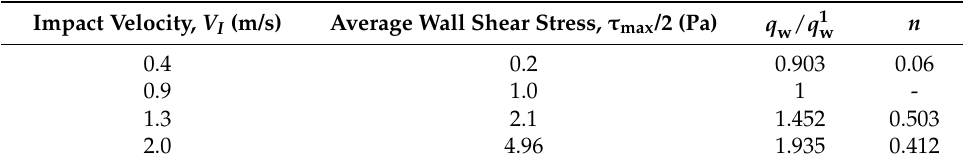
Table 9. Estimated average wall shear stress for the laboratory experiments using Bradshaw and Love results [32]. The ratio q w / q 1 w was obtained from Figure